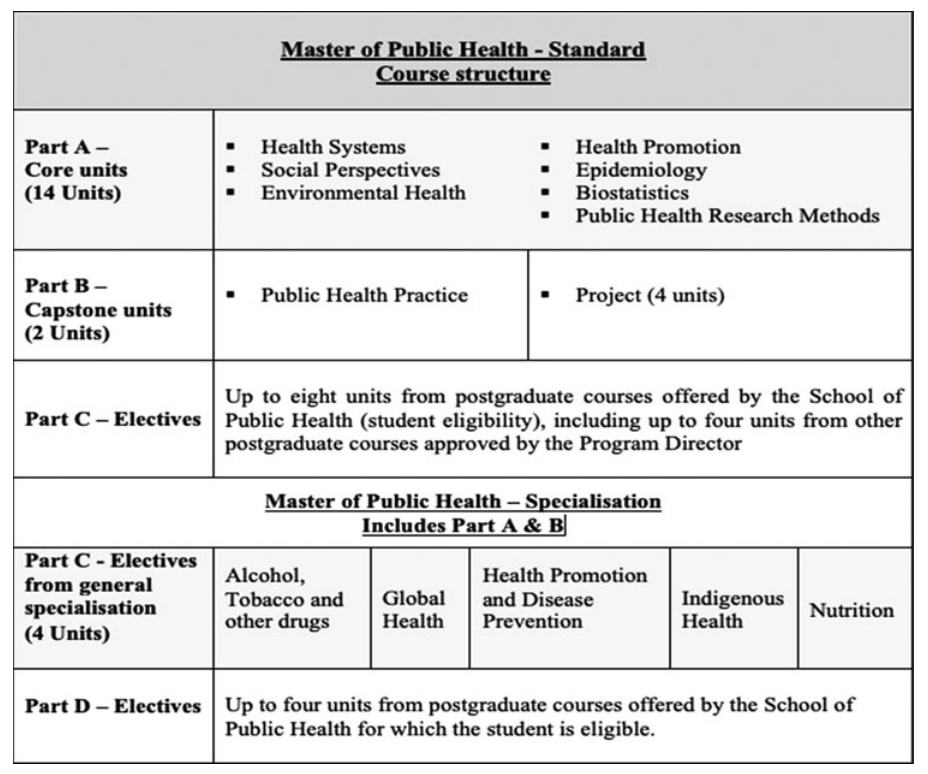
Figure 1. Master of Public Health Program – Course Structure, UQ